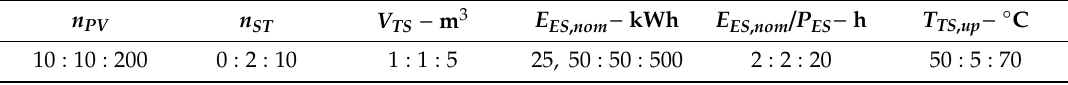
Table 3. Ranges for the six design variables.